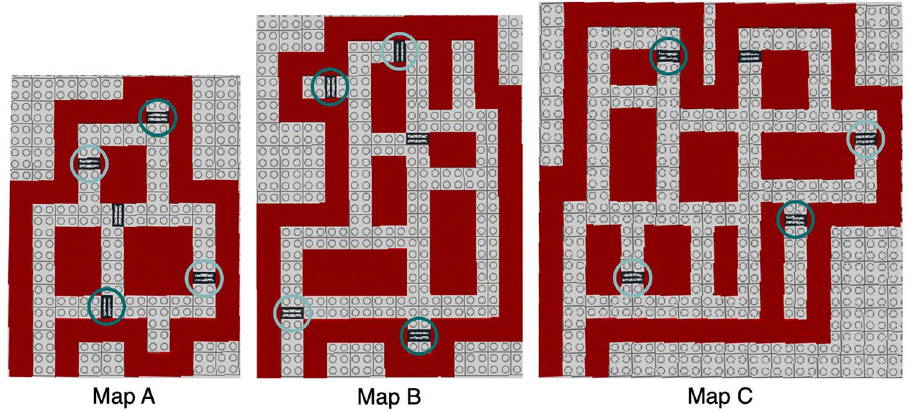
Figure 2. Routes for the navigation task. Subjects had to navigate the shortest route between the items that were associated to the predetermined locations with light circles, and between the ones with dark